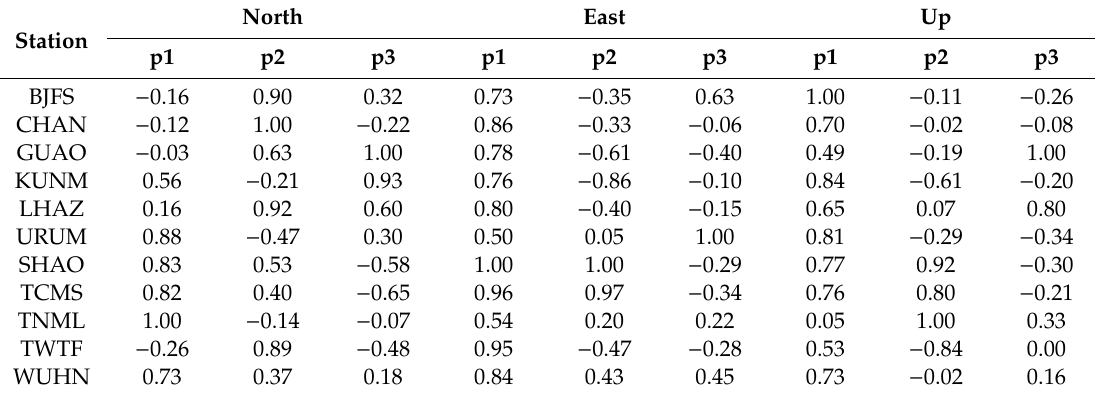
Table 2. Eigenvectors of the first three PCs from IGS stations in